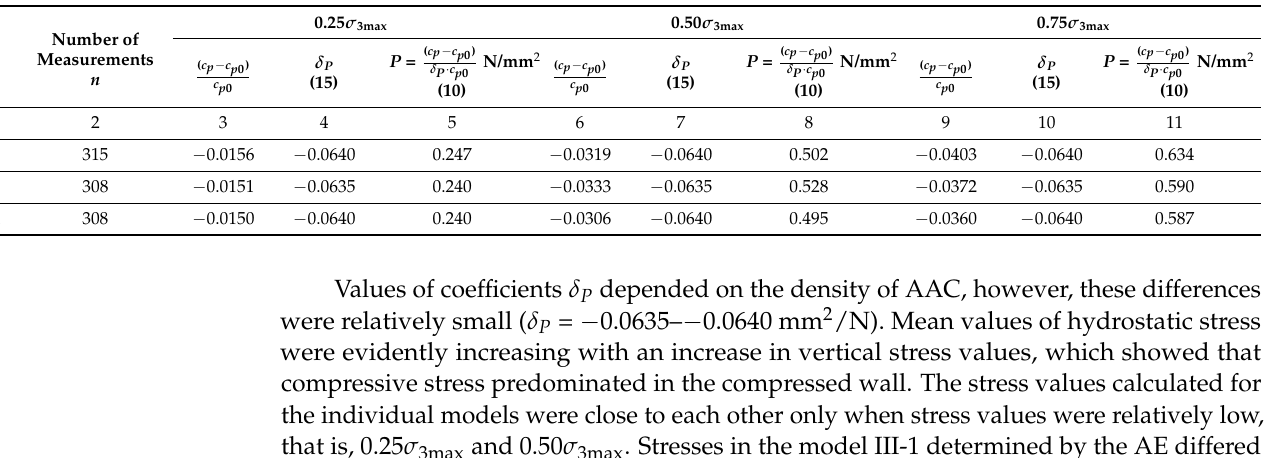
Table 6. Calculated mean values of hydrostatic stress in the wall using all measuring